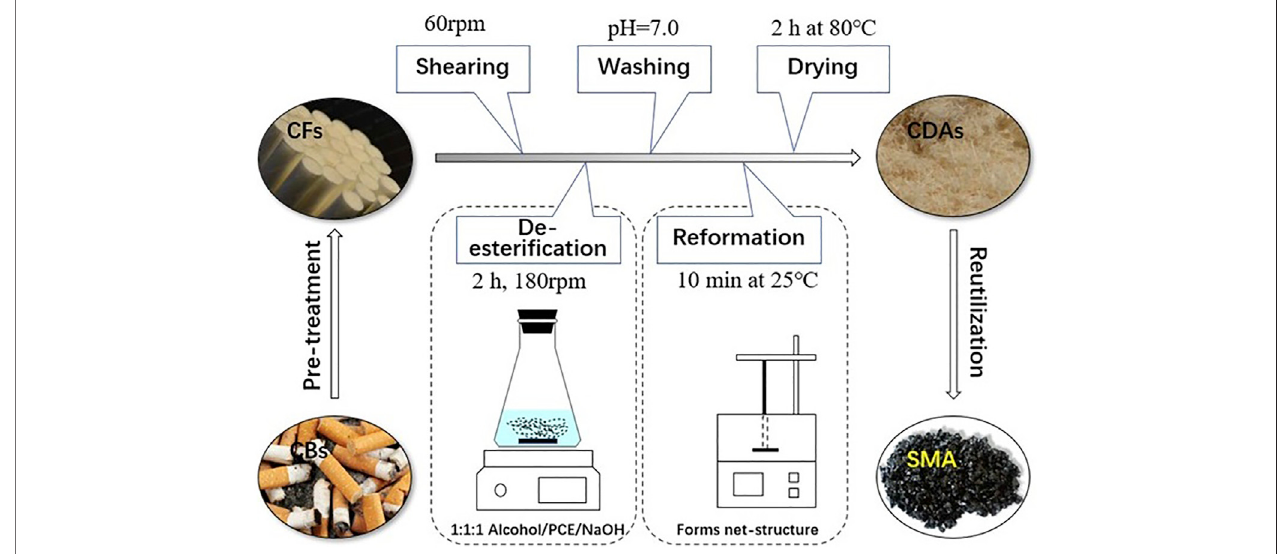
FIGURE 1 | A schematic diagram for reutilization of waste cigarette butts (CFs, cigarette fi lters; CDAs, cellulose diacetates).